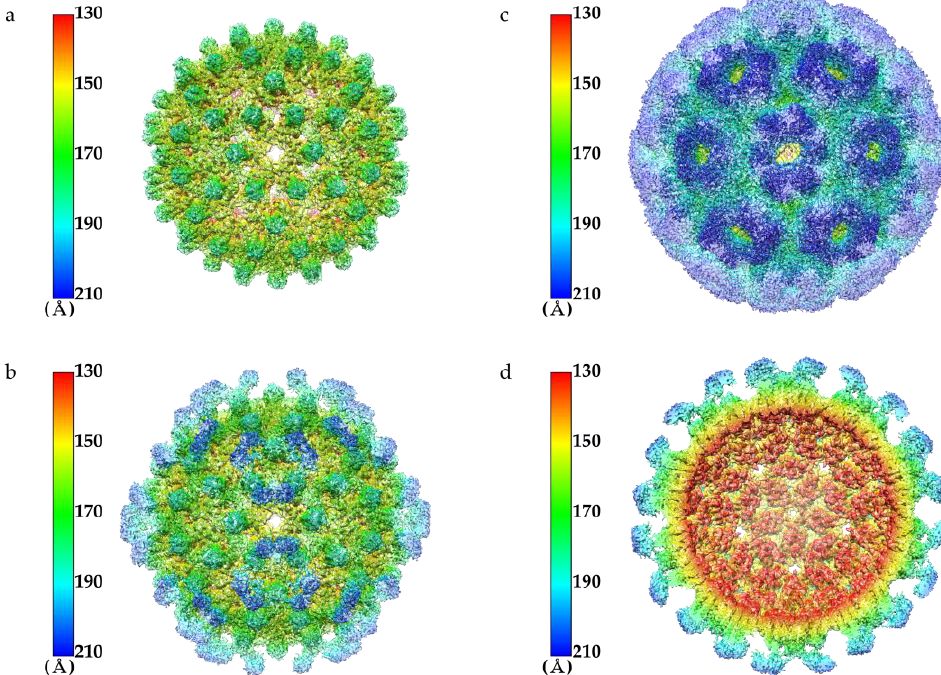
Figure 5. The cryo-EM structures of HAFS (T = 4 state). ( a ) The density map of HAFS was colored by radius and contoured at the threshold value of 0.44 to illustrate the capsid density. ( b ) The density map of HAFS was contoured at the threshold value of 0.33 to illustrate the affibody density. Part of the affibody density is visible. ( c ) The density map of HAFS was contoured at the threshold value of 0.11 to highlight the affibody density. The affibody density is fully visible. ( d ) The density map of HAFS was cut and contoured at the threshold value of 0.33 to illustrate the inner part and cross-section of the affibody. The density map and molecular structure of HAFS were superimposed in this figure.